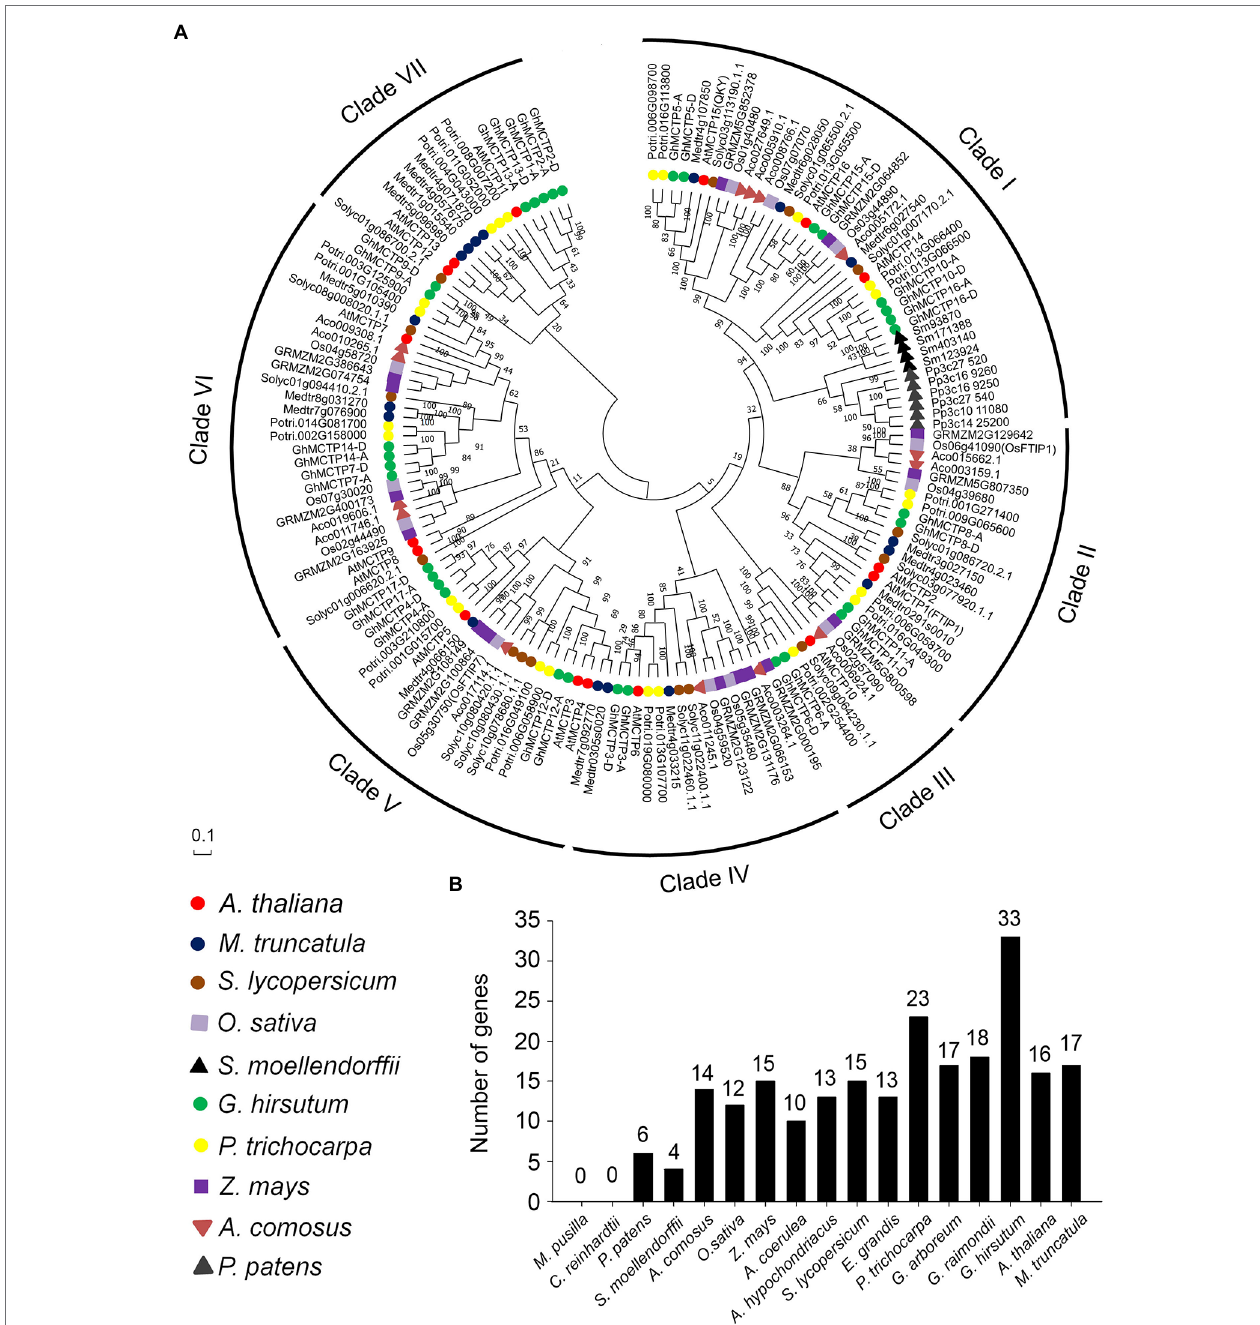
FIGURE 2 | Polygenetic relationships of MCTP homologs in different plant species. (A) Proteins from 10 different species ( Arabidopsis thaliana , Medicago truncatula , Solanum lycopersicum , Oryza sativa , Selaginella moellendorffii , G. hirsutum , Populus trichocarpa , Zea mays , Ananas comosus , and Physcomitrella patens ) are indicated by different icons and are classified into seven groups. All available gene names are also indicated. The level of statistical support was conducted by neighbor-joining method, and numbers on the major branches indicate bootstrap values. (B) Numbers of MCTP genes in different